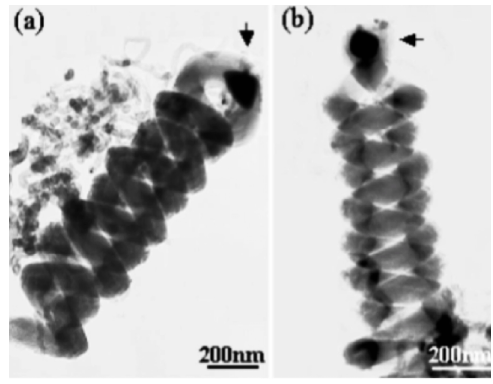
Figure 2. TEM images of double helical CNCs grown by Ni–W–P catalyst [23]. Reprinted with permission from [23], Copyright 2004 AIP Publishing